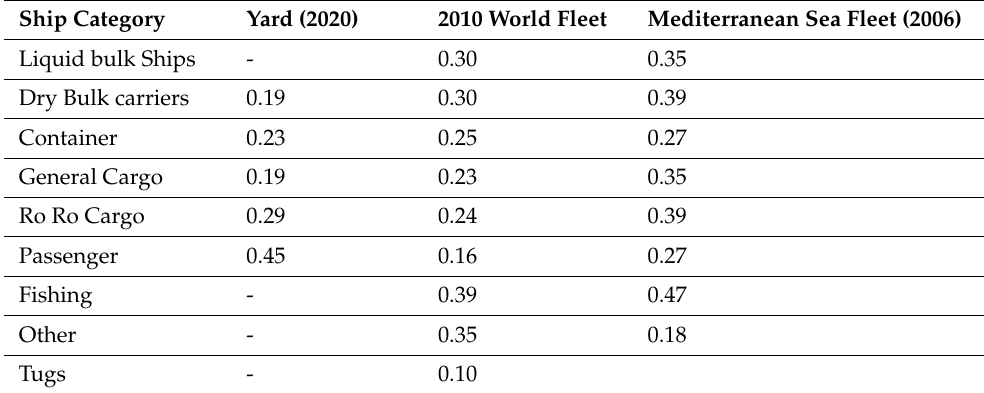
Table 9. Estimated average ship ratio of auxiliary engine/main engine by ship